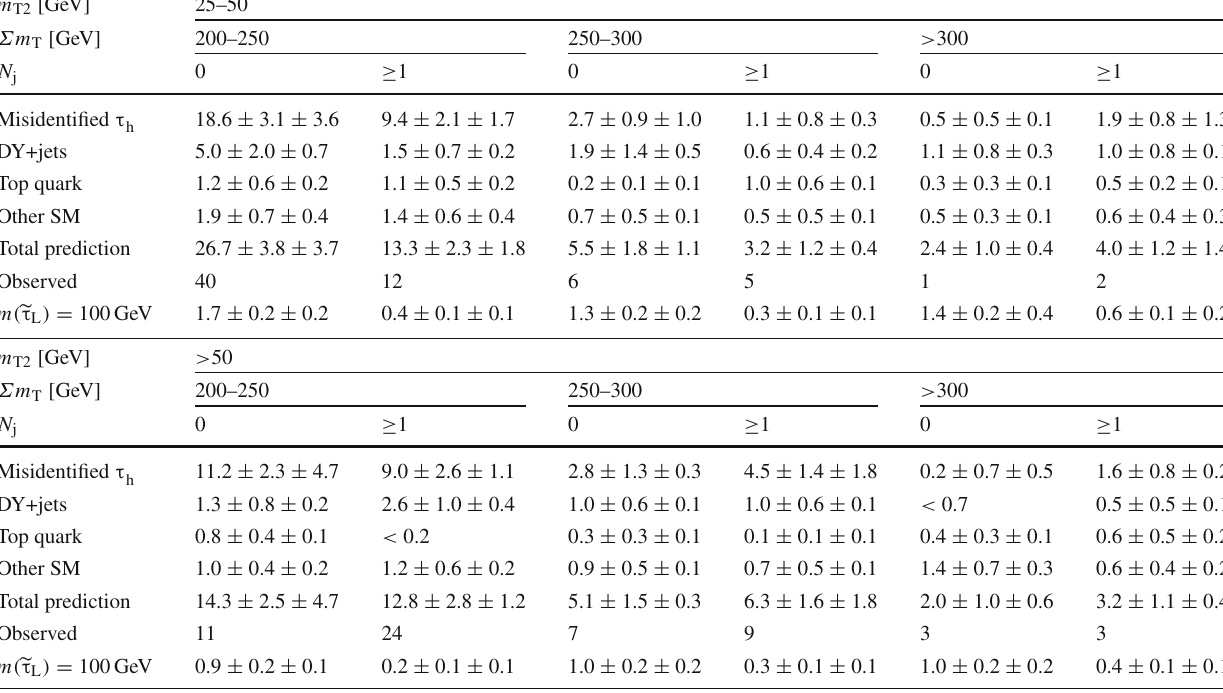
Table 4 Predicted background yields and observed event counts in τ τ SRs in 2017 data. For the background estimates with no events h h in the sideband or in the simulated sample, we calculate the 68% CL upper limit on the yield. The first and second uncertainties given are